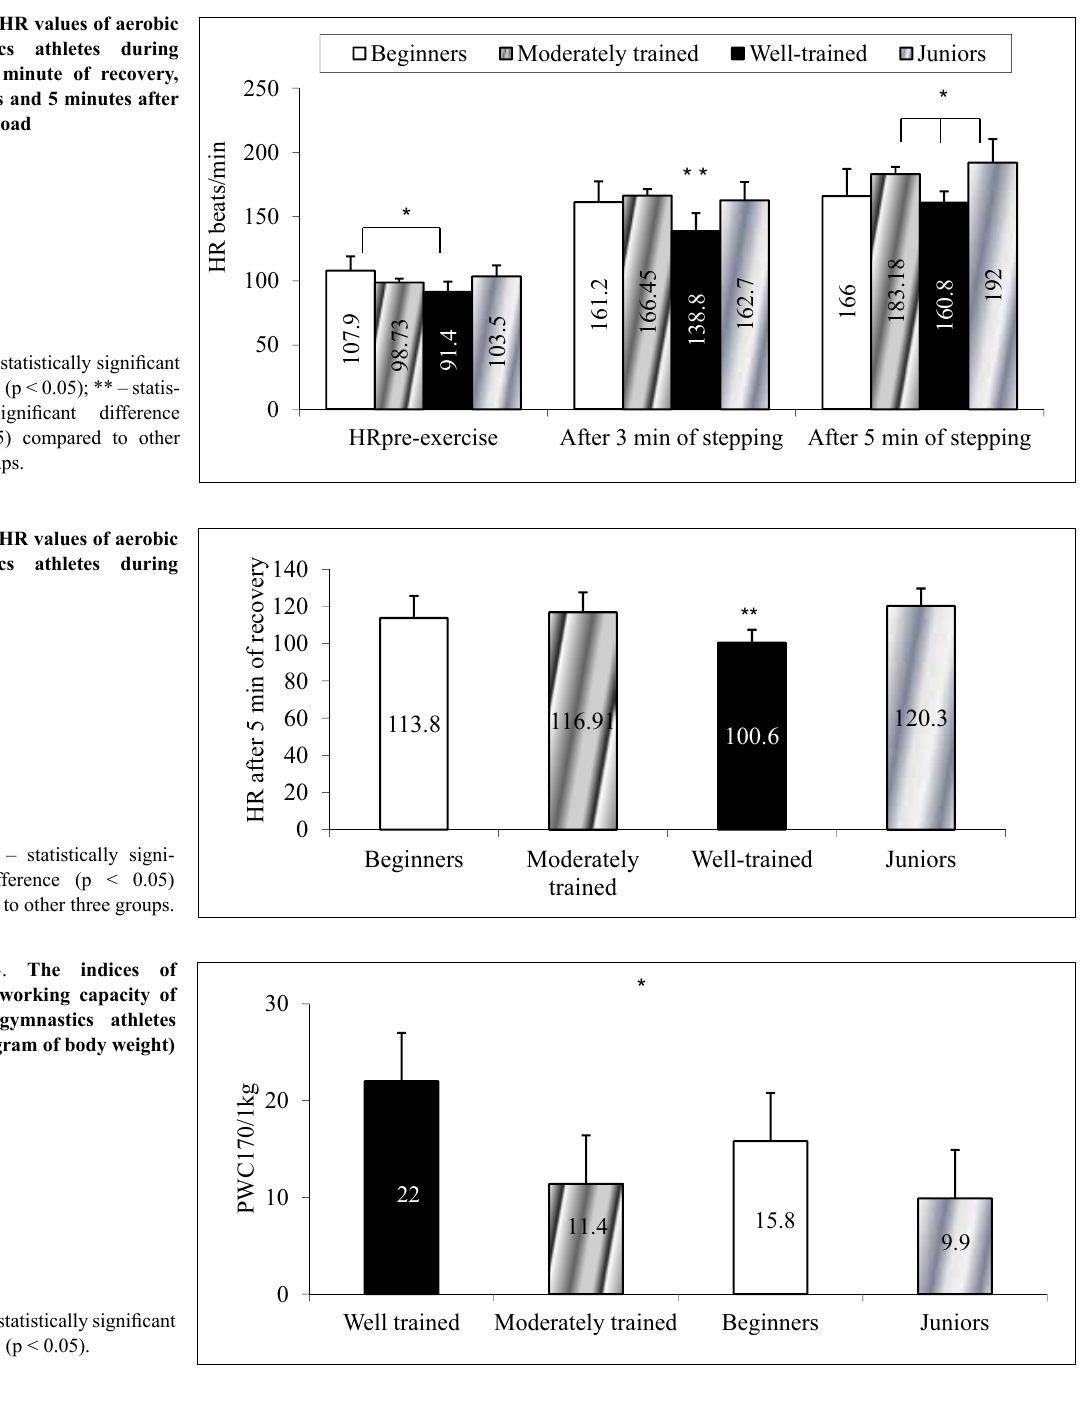
Figure 3. The indices of physical working capacity of aerobic gymnastics athletes